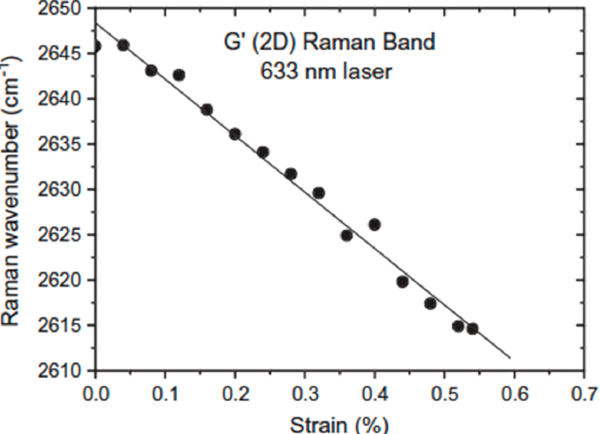
Figure 4. Shift of the Raman 2D band with strain for a graphene monolayer. Reproduced with permission from [75].